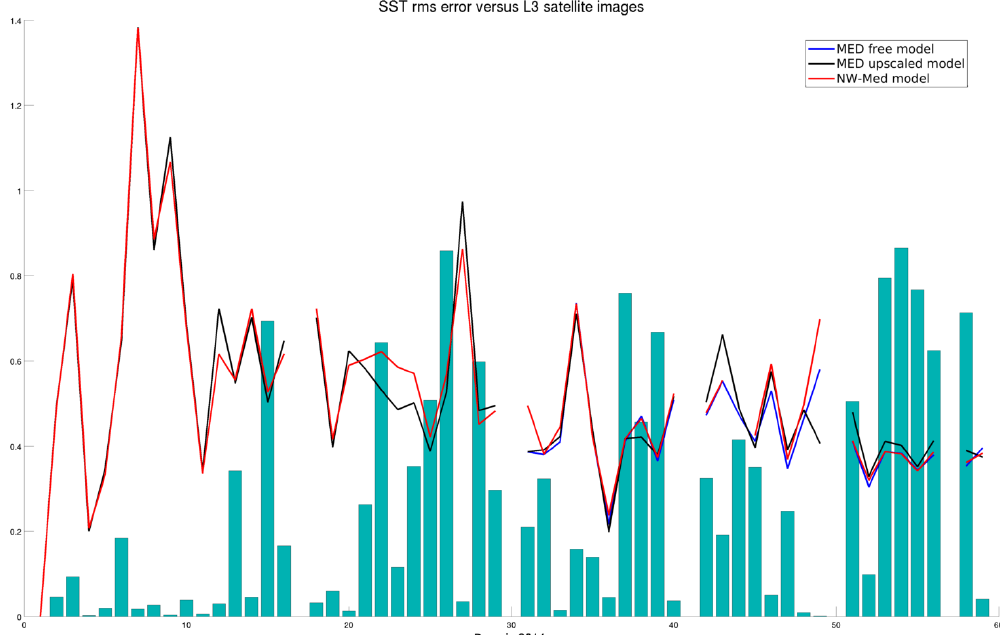
Figure 10. SST rms error in the free model (black curve), nested model (red curve) and upscaled model (blue curve) during the first 2 months of simulation. The bars represent the proportion of unclouded points in the L3 satellite image.